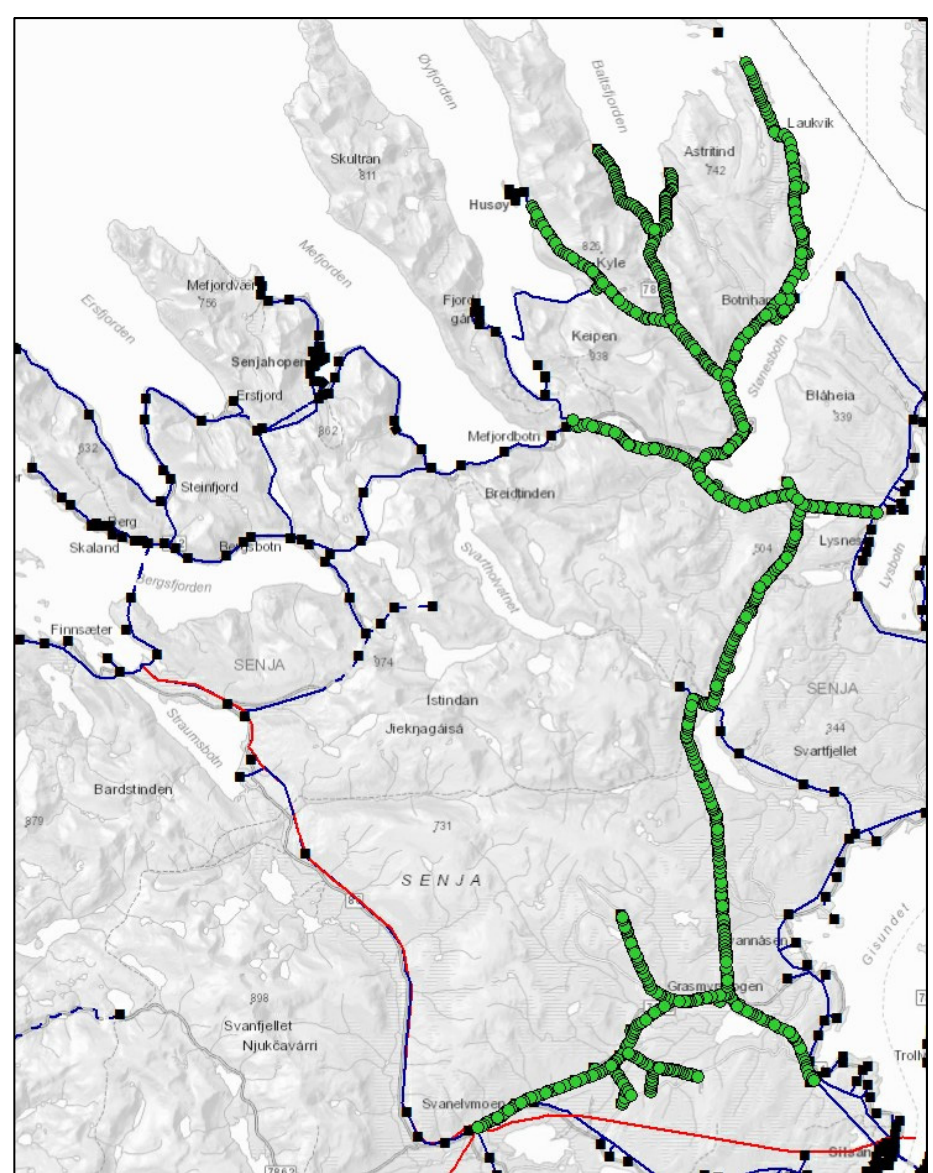
Figure 1. The SVAN22LY1 radial power grid. The power flows from the south toward the north. The green dots represent the position of a utility pole that supports the power lines.